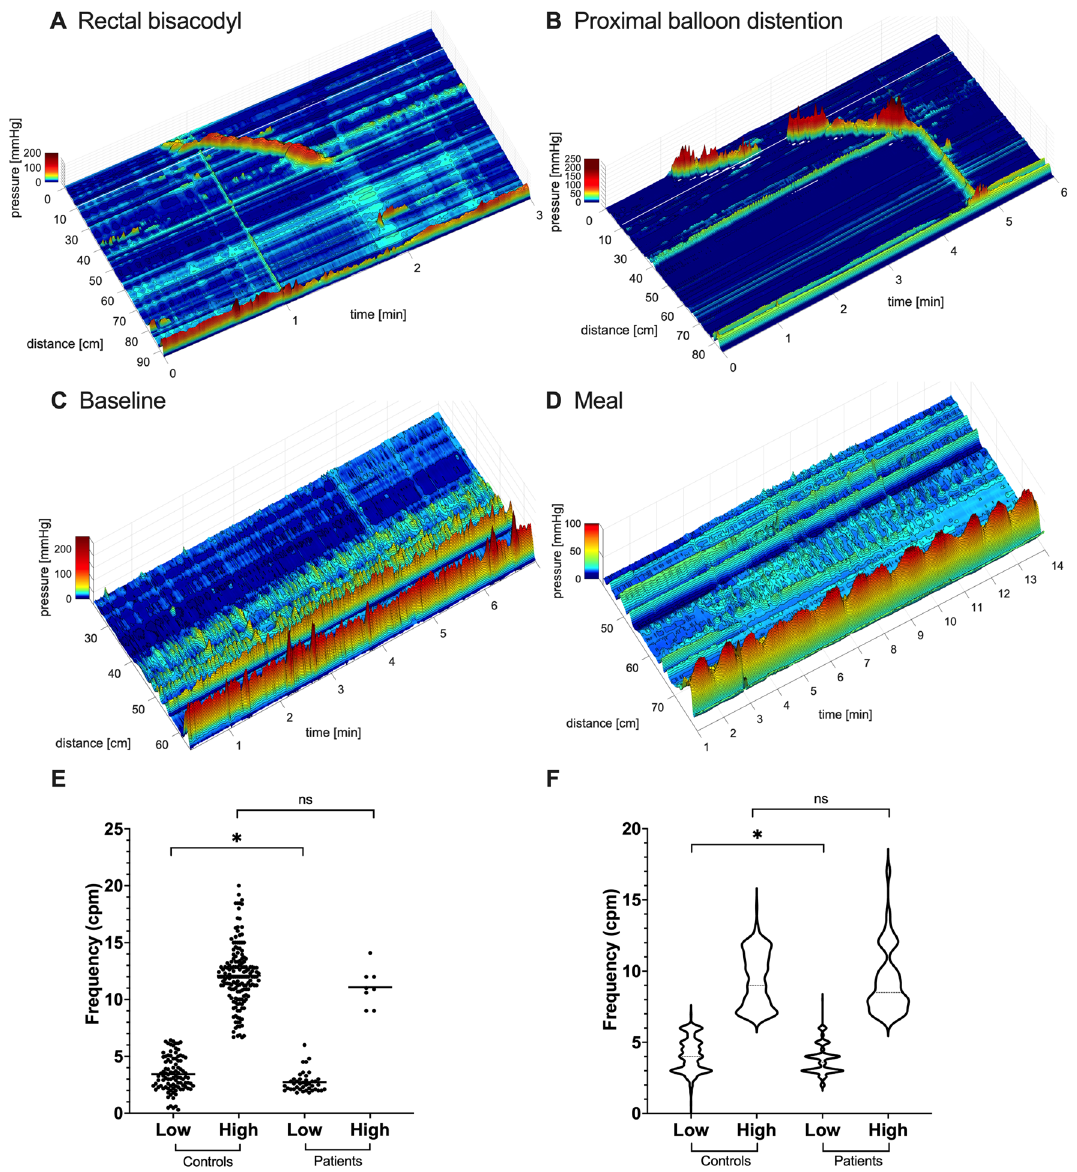
Figure 2. Colonic motor activity: high-amplitude propagating pressure waves (HAPWs), high and low frequency cyclic motor patterns (CMPs), and haustral activity in patients. ( A ) Rectal bisacodyl evoked an HAPW that originated in the ascending colon (at 0 cm) and propagated into the descending colon (at 42 cm) in patient #6. This shows evidence of both vagal and sacral pathway activity. Patient #6 also showed a normal coloanal reflex: HAPW associated anal sphincter (at 89 cm) relaxation without persistent sphincter of O’Beirne (at 75 cm) activity. The white line represents a gap of 10 cm where a balloon was attached to the catheter. ( B ) PBD evoked an HAPW that originated in the ascending colon (at 0 cm) in patient #4. This shows evidence of vagal pathway activity and evidence of coloanal dyssynergia: the HAPW is associated with anal sphincter contraction (at 80 cm). The white line represents a gap of 10 cm where a balloon was attached to the catheter. ( C ) During baseline, a retrograde propagating high frequency cyclic motor pattern (at 40–52 cm) was observed with sphincter of O’Beirne activity (at 55 cm) and a high anal sphincter pressure (at 63 cm) in patient #12. ( D ) In response to a meal, retrograde propagating low frequency cyclic motor patterns (at 55–62 cm) and rhythmic high amplitude anal sphincter pressure activity (at 73 cm) were observed in patient #3. ( E ) Each dot represents the average intrinsic pressure wave frequency within a single cyclic motor pattern. Mean value is shown as a black line. There were more high frequency CMPs than low frequency CMPs in controls, whereas in patients there were more low frequency CMPs compared to high frequency. Controls: low frequency (n = 99), high frequency (n = 164). Patients: low frequency (n = 42), high frequency (n = 8). ( F ) The average frequency of the low frequency haustral activity is significantly lower in the patient group (P < 0.0001). Controls: low frequency (n = 563, N = 21), high frequency (n = 160, N = 21). Patients: low frequency (n = 505, N = 14), high frequency (n = 40, N = 14). Low frequency controls vs patients: 4.1 ± 1.2 cpm vs 3.7 ± 1.0 cpm. High frequency controls vs patients: 9.4 ± 1.9 cpm vs 9.3 ± 2.3